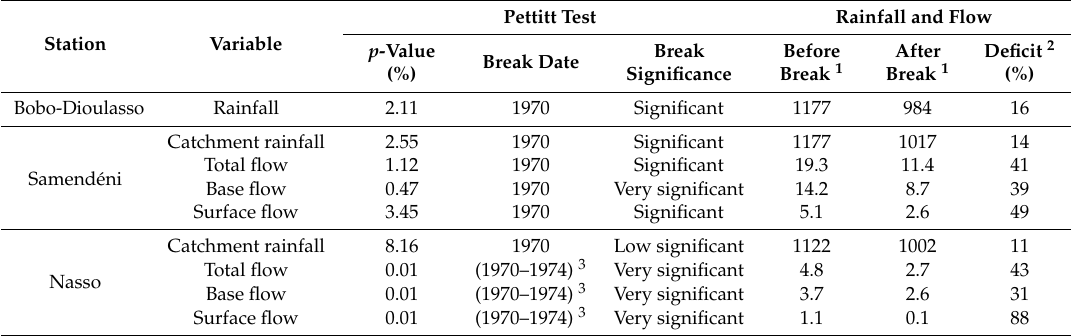
Table 4. Results of the break test on Samendéni and Nasso station flows over the period from 1961 to 1997.